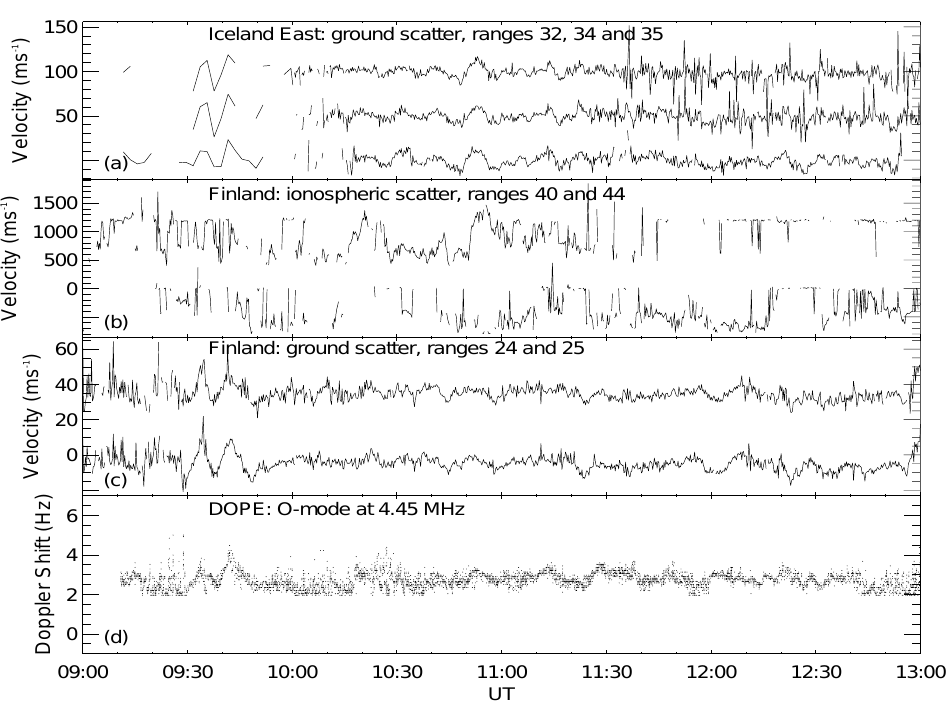
Fig. 4. Stacked velocity-time plot of CUTLASS and DOPE Doppler oscillations, 09:00–13:00UT, 23 February 1996. The same CUTLASS beams are shown as in Fig. 3. The panels show, from top to bottom, Iceland East ground scatter, Finland ionospheric scatter, Finland ground scatter, and HF Doppler